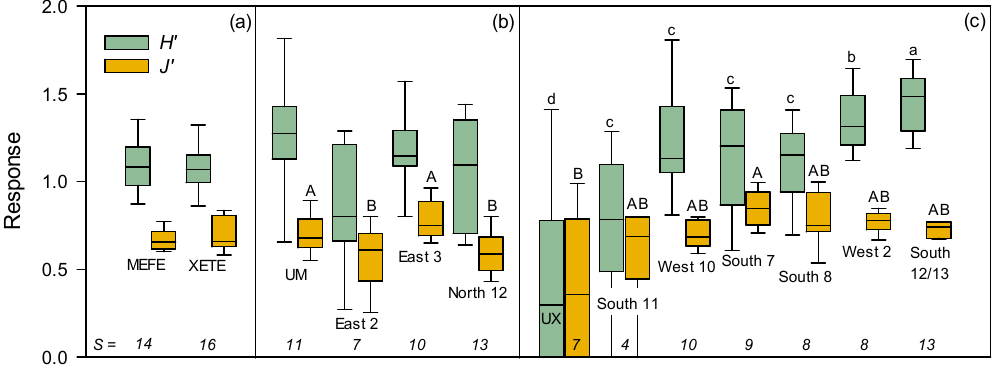
Figure 3. Species richness ( S ) and box plots for Shannon functions of species diversity ( H ′ ) and evenness ( J ′ ) for the 11 disturbance categories (see Table 1 for descriptions) on the Miller Creek Demonstration Forest 30 years after the disturbances: ( a ) no significant differences were observed between the Menziesia ferruginea (MEFE) and Xerophyllum tenax (XETE) phases within the Abies lasiocarpa / Clintonia uniflora habitat type ( p = 0.3568), and H ′ was less variable ( p = 0.7316) than J ′ ( p = 0.4819); ( b ) responses within the MEFE disturbance categories were significant ( p = 0.0027); H ′ was less variable ( p = 0.0339) than J ′ ( p = 0.0048); ( c ) responses within the XETE disturbance categories were significant ( p < 0.0001); H ′ was less variable ( p < 0.0001) than J ′ ( p = 0.0001). Within panels b and c, x-axis values progress from undisturbed forest (left) to the highest severity disturbance (right). Larger values of H ′ indicate increasing levels of biodiversity as a function of abundance, whereas larger values of J ′ reflect more consistent abundance across species observed in each disturbance category. Vertical boxes represent approximately 50% of the observations, lines extending from each box are the upper and lower 25% of the distribution, and the solid horizontal line in the center of each box is the median value. Di ff erent lowercase ( H (cid:48) ) and uppercase ( J (cid:48) ) letters within habitat type phases and panels indicate significant di ff erences